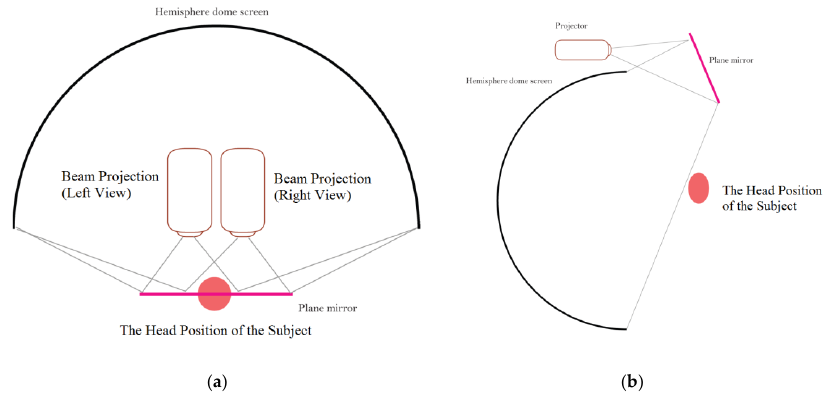
Figure 4. 3D cyber dome profile: Kyushu University in Japan. ( a ) Position of beam projection from above, ( b ) Position of beam projection from side.